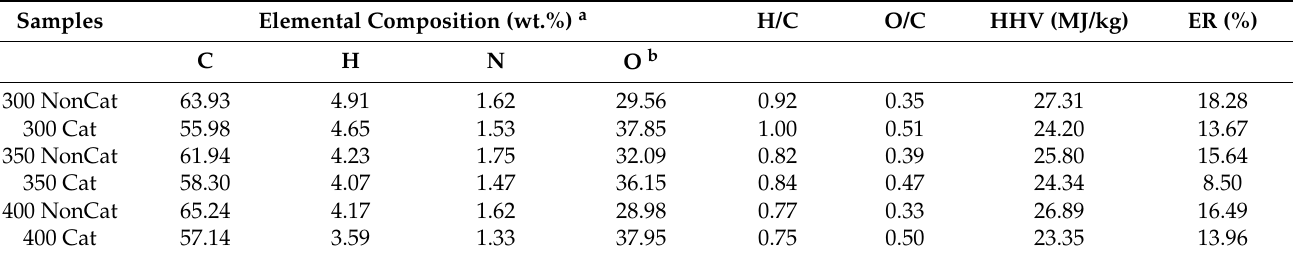
Table 4. Analysis of Solid